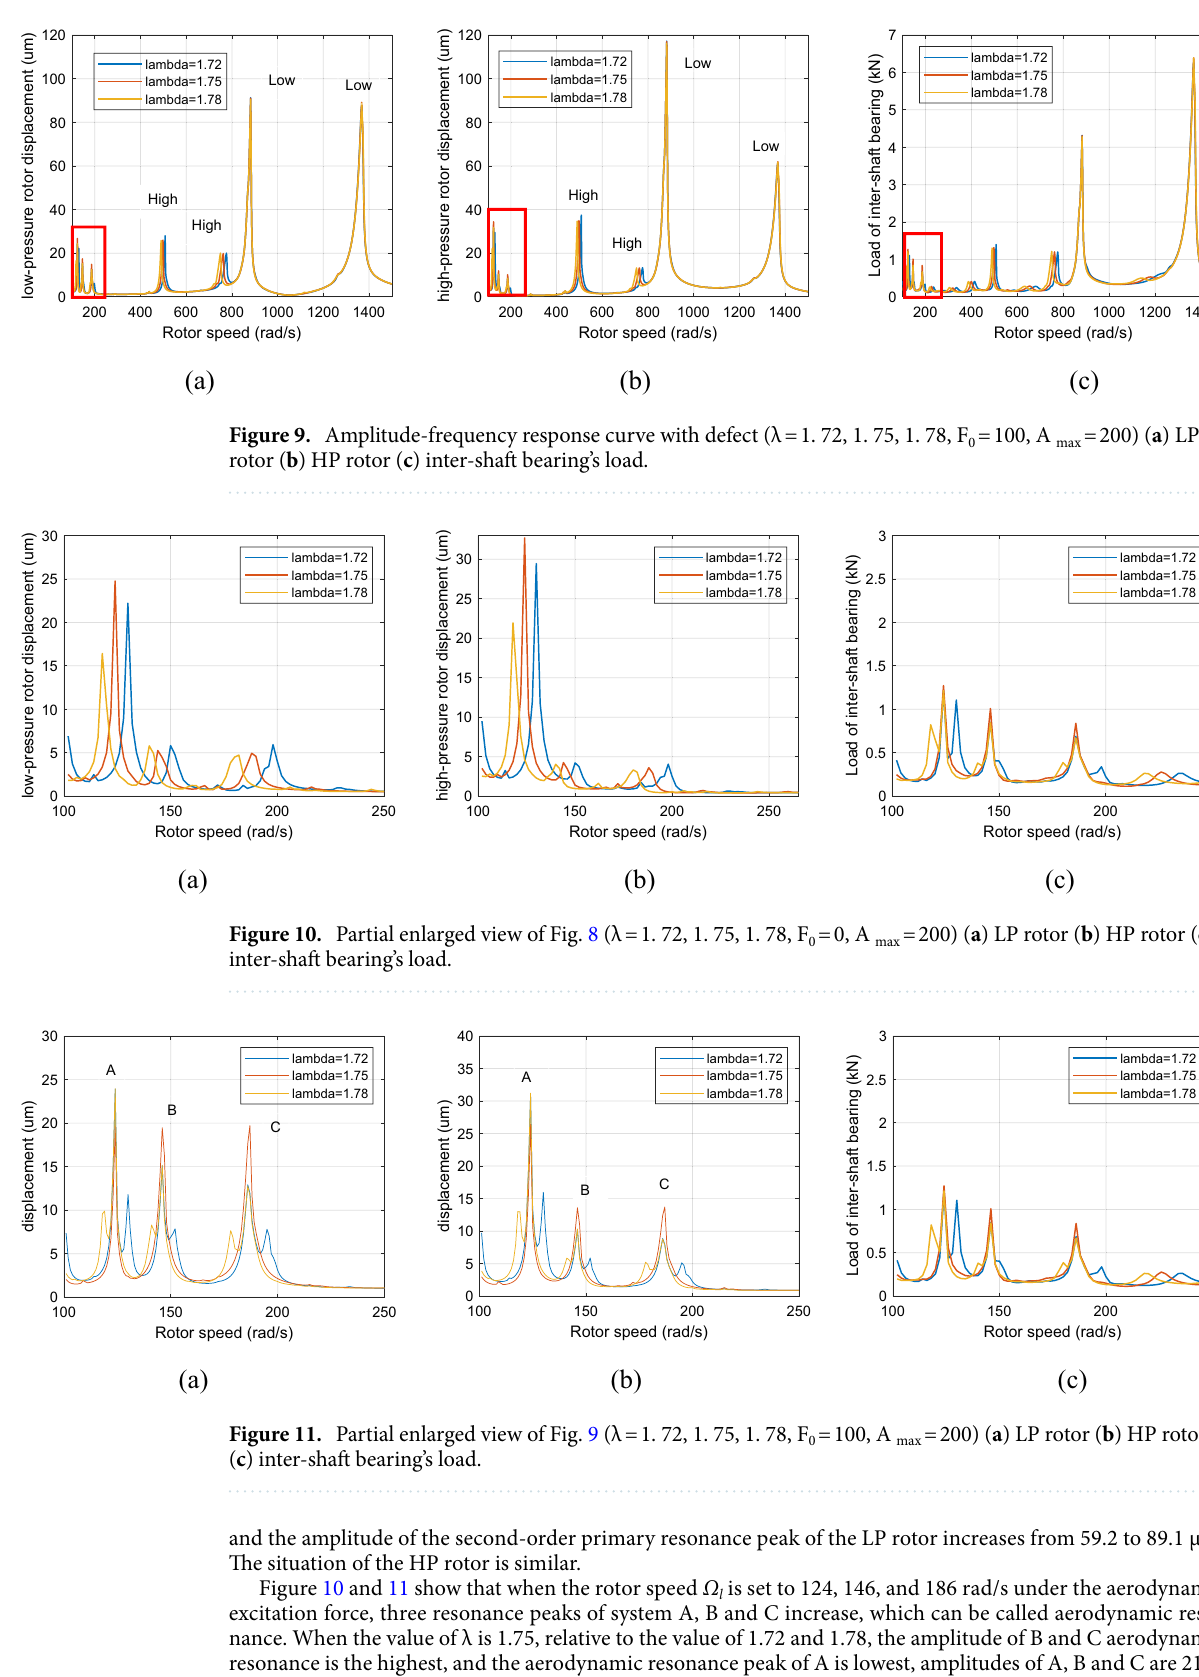
and the amplitude of the second-order primary resonance peak of the LP rotor increases from 59.2 to 89.1 μm. The situation of the HP rotor is similar. Figure 10 and 11 show that when the rotor speed Ω l is set to 124, 146, and 186 rad/s under the aerodynamic excitation force, three resonance peaks of system A, B and C increase, which can be called aerodynamic reso- nance. When the value of λ is 1.75, relative to the value of 1.72 and 1.78, the amplitude of B and C aerodynamic resonance is the highest, and the aerodynamic resonance peak of A is lowest, amplitudes of A, B and C are 21.3, 19.2, 17.3 μm respectively. Figures 10c and 11c show that aerodynamic excitation force amplifies the load of the inter-shaft bearing. While the system runs under the synchronous impact (λ = 1.75), the inter-shaft bearing’s